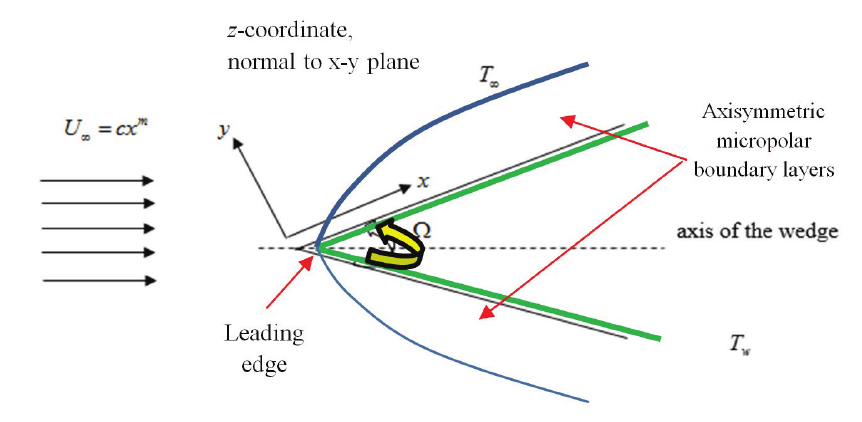
Fig. 1 – Physical model and coordinate